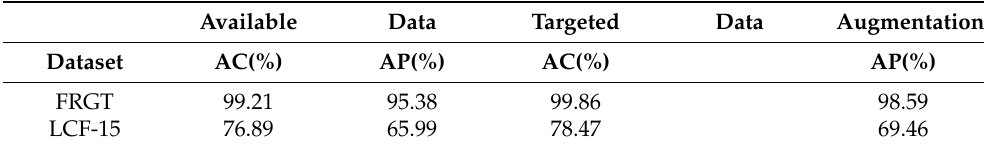
Table 4. Performance comparison with and without targeted data augmentation on the FRGT and LCF-15 datasets. Available Data Targeted Data